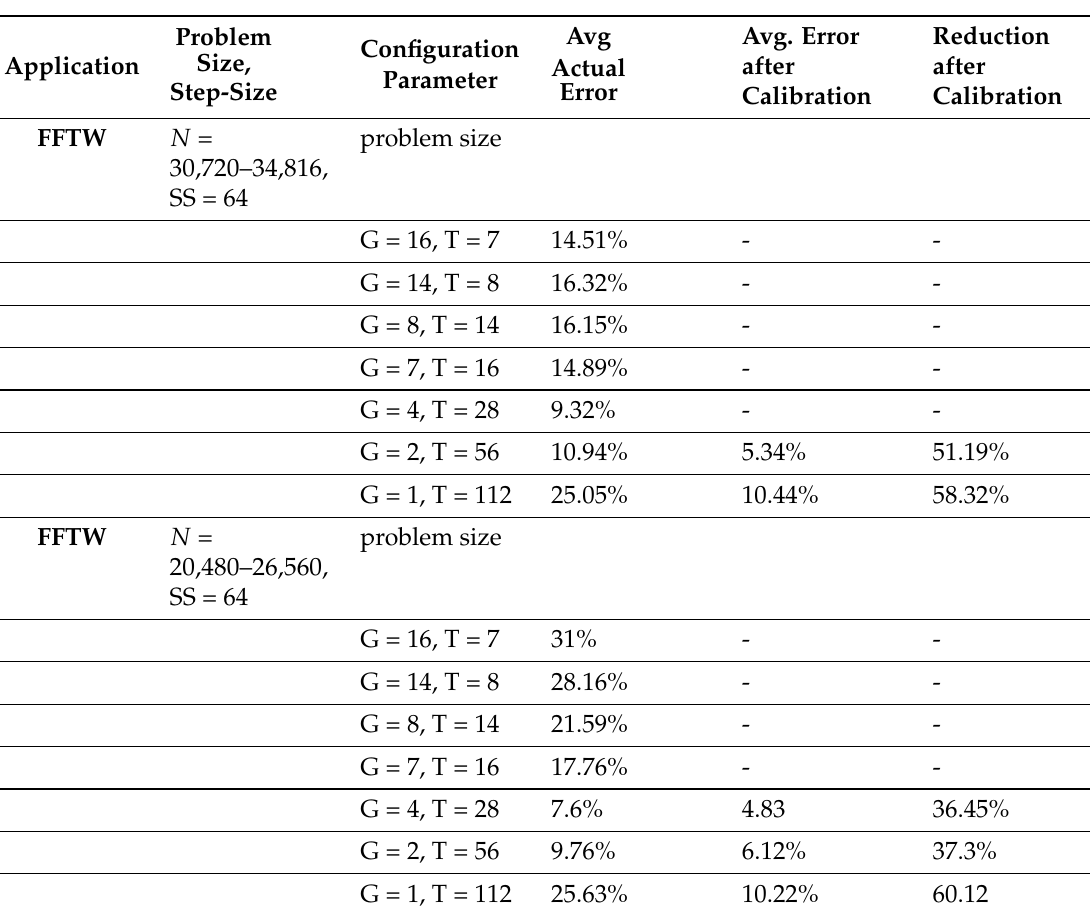
Table A3. Percentage error of dynamic energy consumption with RAPL and HCLWattsUp on HCLServer03. ’-’ denotes that calibration does not be improve the